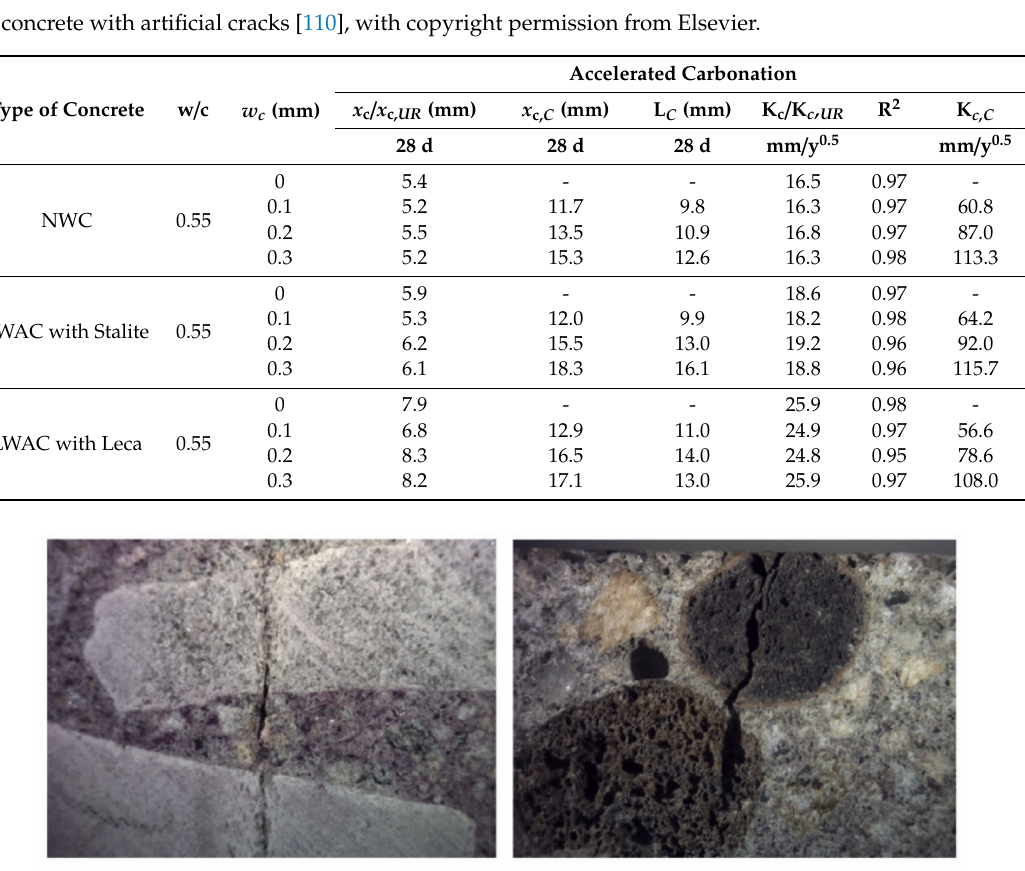
Figure 12. Natural crack crossing through the aggregate in NWC ( left ) and LWAC ( right ) [110], with copyright permission from